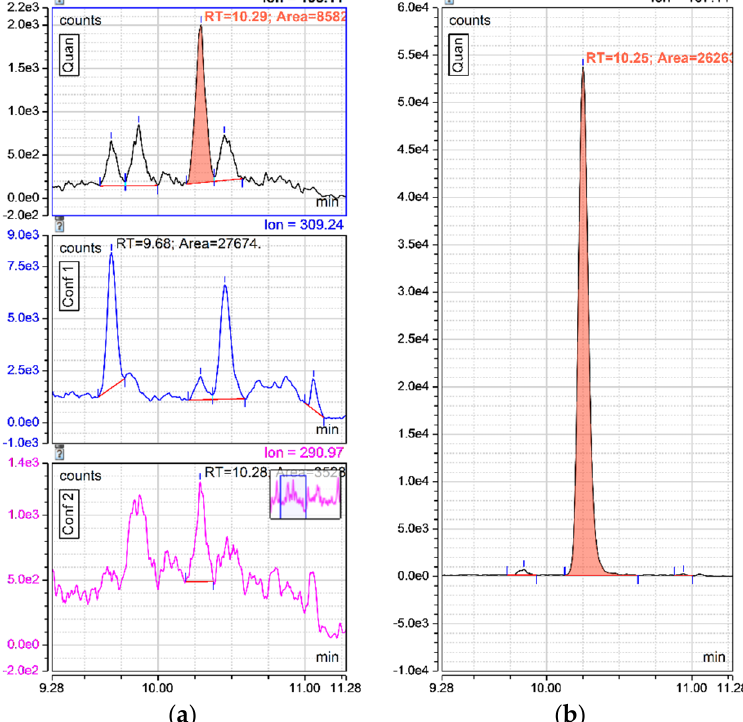
Figure 4. ( a ) MRM transitions for 8-isoprostane in “light urine”; presence of potential other F 2 - isoprostane isomers; ( b ) corresponding 8-isoprostane-d 4 chromatogram.